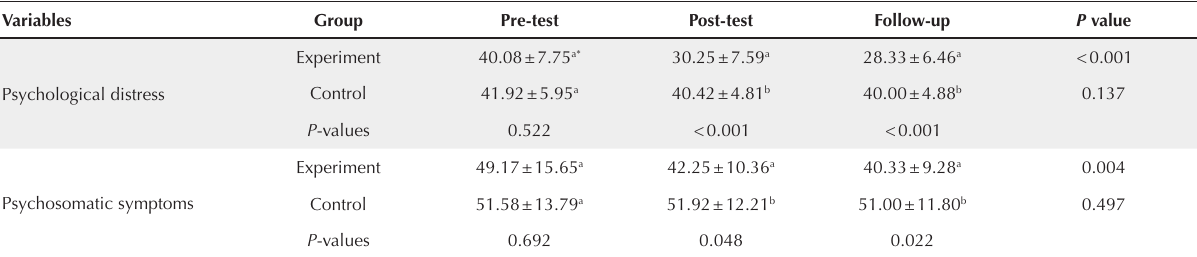
Table 3. The comparison of psychological distress and psychosomatic symptoms over time and between group Variables